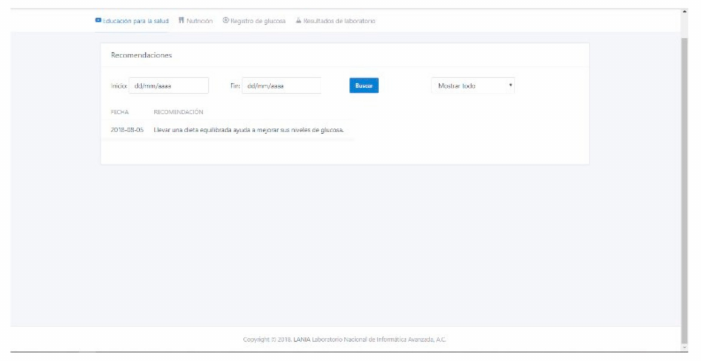
Figure 42. Patient application interface: food menus assigned by the 7.